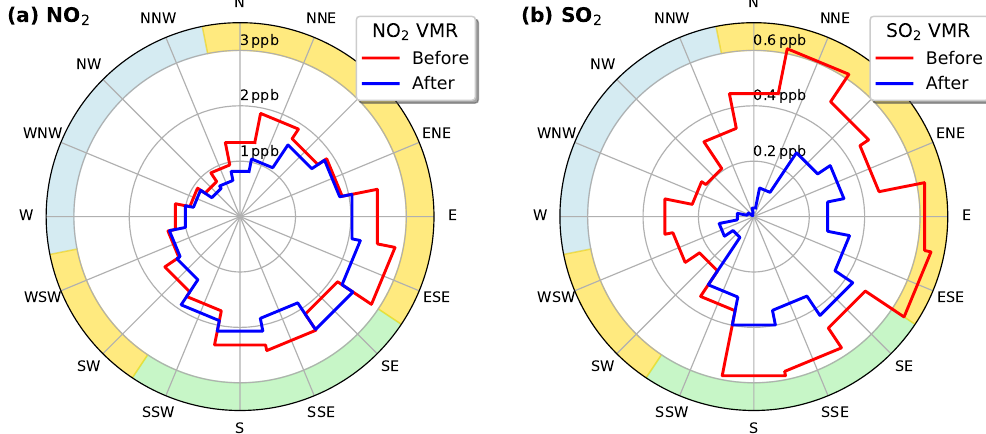
Figure 16. Wind direction distribution of the measured NO 2 (a) and SO 2 (b) volume mixing ratios at 0.5 ◦ elevation before and after the change in fuel sulfur limit regulations on 1 January 2015. The colored sectors show directions with wind mainly from land (green), open North Sea (blue) and mixed origin (yellow).